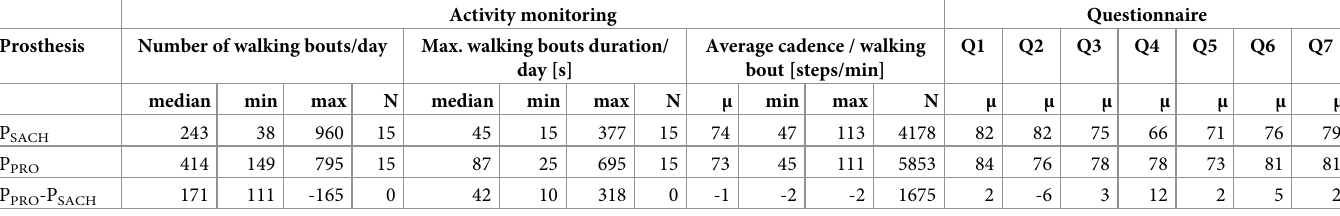
& The Qi indices correspond to the following questions: (1) stability while standing, (2) stability while walking, (3) powerful push-off, (4) feeling of firm contact with the ground, (5) weight of the foot, (6) comfort of the foot and (7) overall score of the prosthesis. In this table, μ represents the